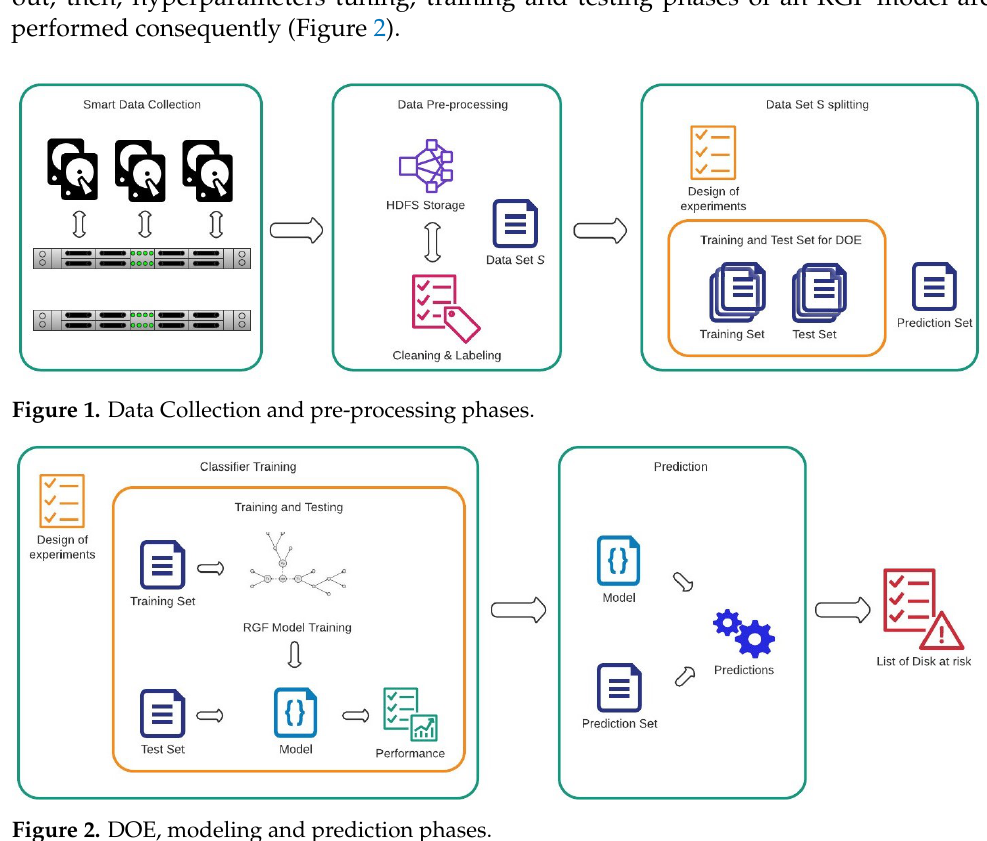
Figure 2. DOE, modeling and prediction